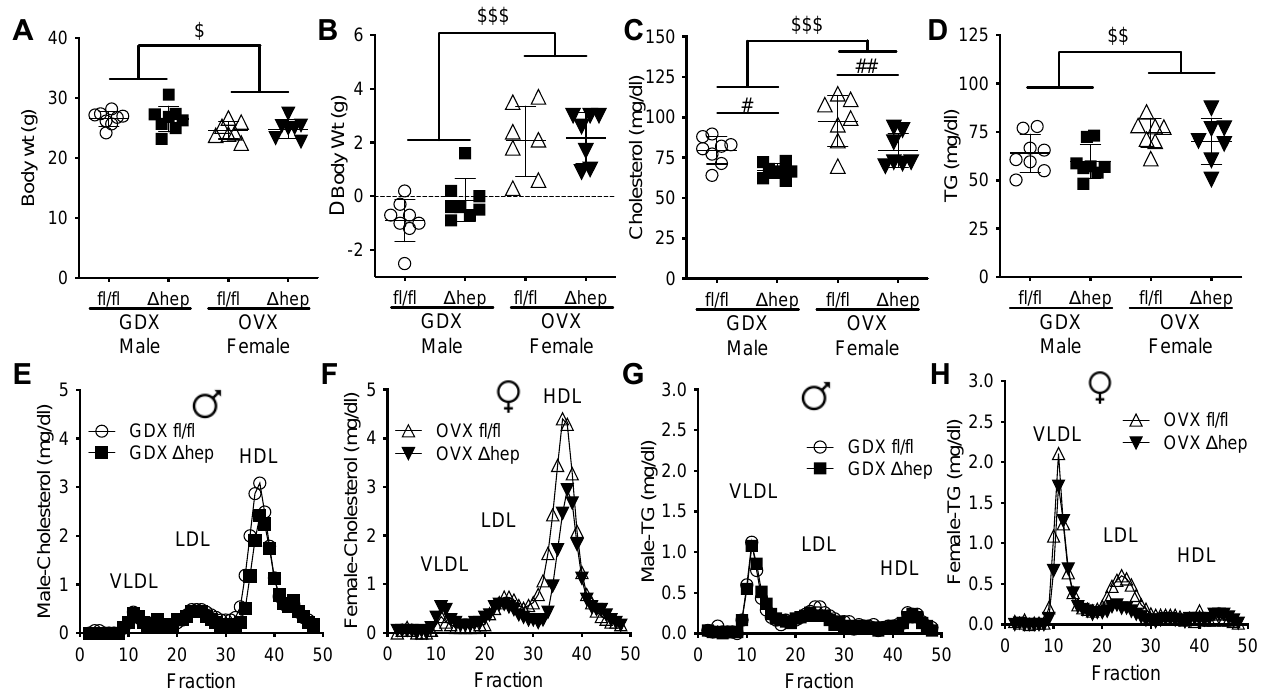
Figure 4. Effect of gonadectomy on hepatic SHP regulation of plasma lipids. Two weeks prior to the study, male and female SHP fl/fl and SHP ∆ hep littermates underwent surgical gonadectomy (GDX) or ovariectomy (OVX). ( A , B ) Body weight ( A ) and body weight change ( B ) after surgery. ( C , D ) Plasma cholesterol ( C ) and TG ( D ). ( E , F ) Pooled plasma was separated into lipoproteins by FPLC. Cholesterol content of lipoproteins in GDX male ( E ) and OVX female ( F ) mice. ( G , H ) TG content of lipoproteins in GDX male ( G ) and OVX female ( H ) mice. Data shown are mean ± SD ( n = 7–8/group), # p < 0.05 and ## p < 0.01 for genotype effects; $ p < 0.05, $$ p < 0.01, and $$$ p < 0.001 for sex effects (2-way ANOVA).